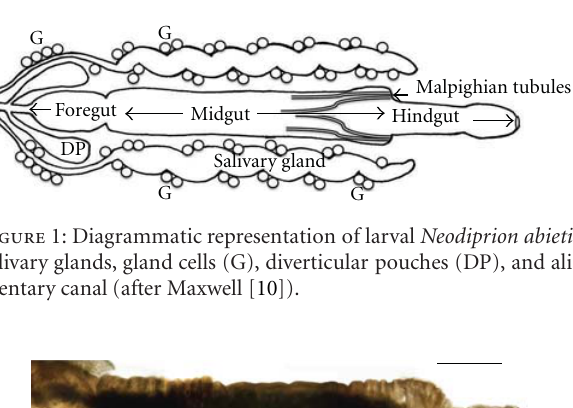
Figure 3: Longitudinal section through the head (H) and thorax (T) of a N. abietis larva showing the paired diverticular pouches (DP) and the tubule (arrows) that connects one of the pouches to the buccal cavity. (Note that serial sections showed the continuity of the tubule between the diverticular pouch and the buccal cavity.) Scale bar = 0.5mm.